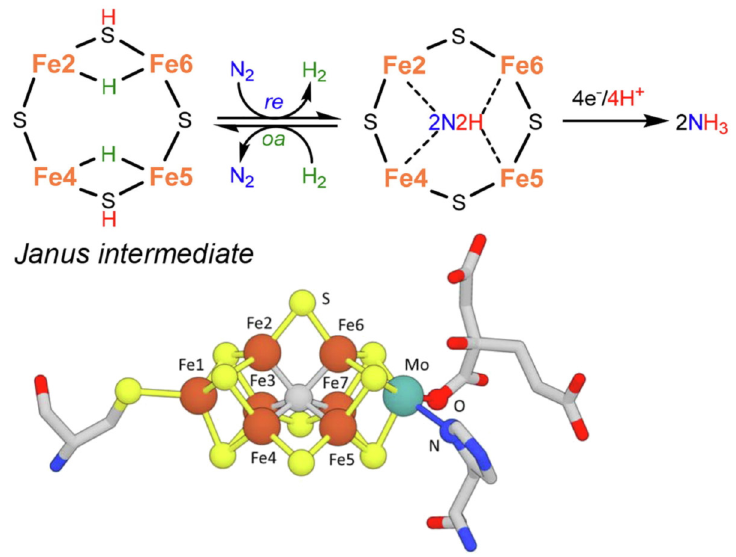
Figure 2. Key step for biological N 2 fixation and structure of nitrogenase FeMo-co. Adapted from [52]. Copyright 2021 Elsevier.